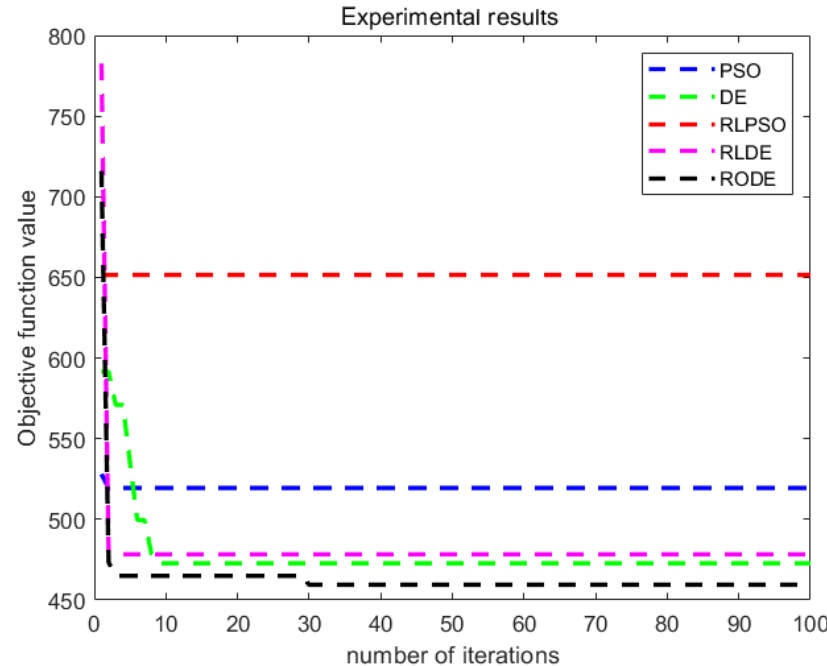
Figure 9. Experimental comparison with an initial population of